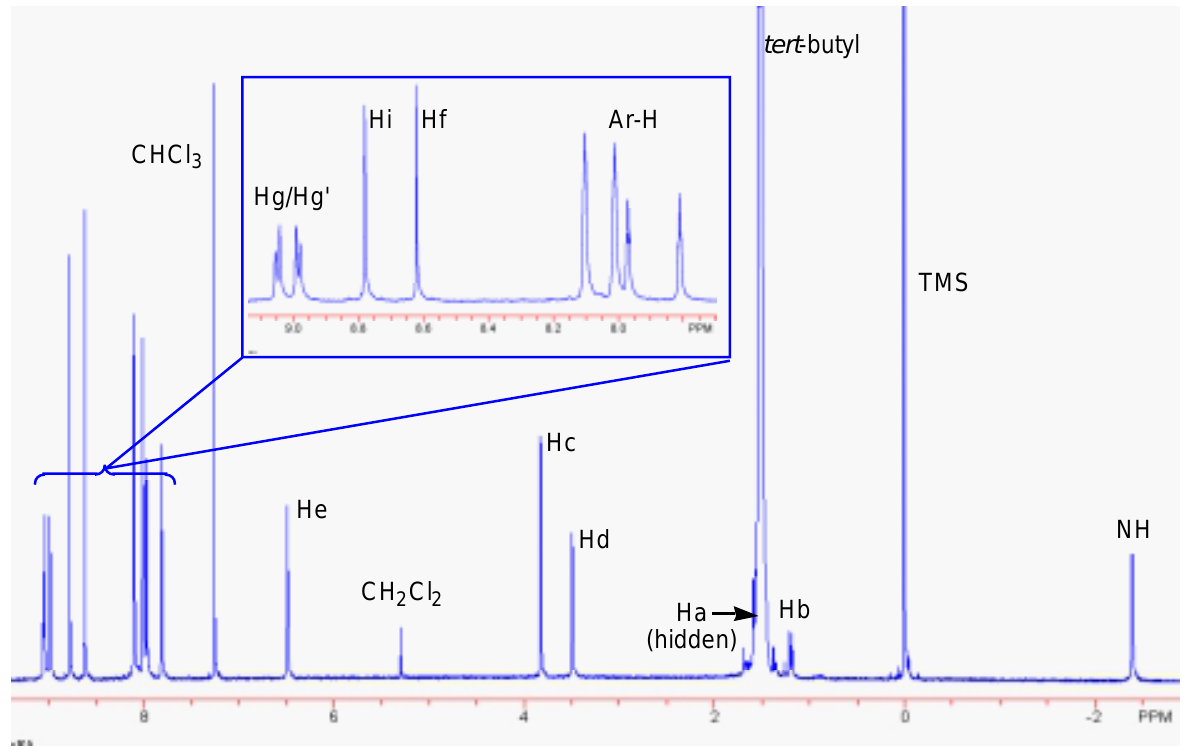
) of porphyrin block 8 3